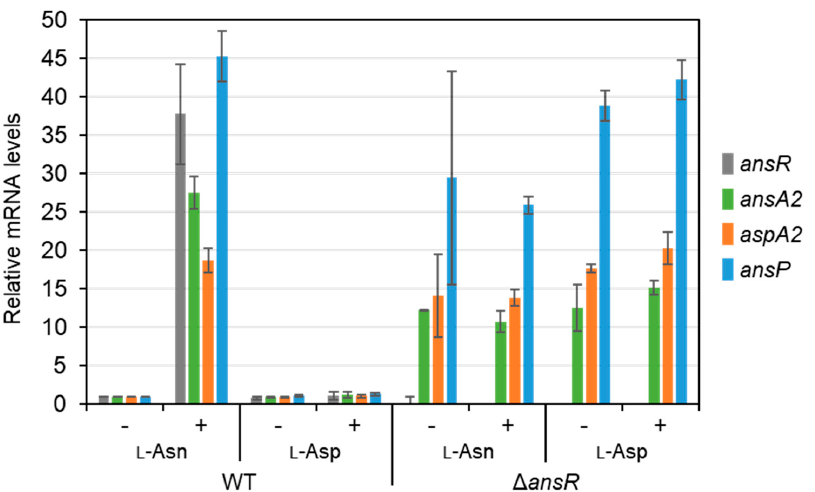
Figure 2. Expression analysis of the ans operon genes in response to the supplementation of L-asparagine or L-aspartate. RNA was extracted before ( − ) or 30 min after (+) the amino acid supplementation. Transcript levels of ansR , ansA2 , aspA2 , and ansP were determined by quantitative reverse-transcription polymerase chain reaction analysis. Transcript levels in the WT before the amino acid supplementation were standardized to 1. Mean values obtained from three independent cultivations are shown with their standard deviations.